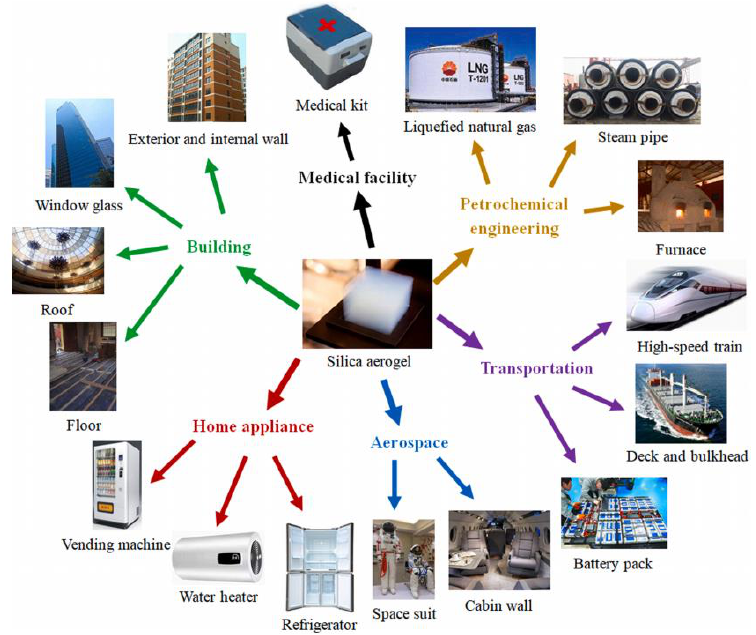
Figure 1. Application range of aerogel [3].